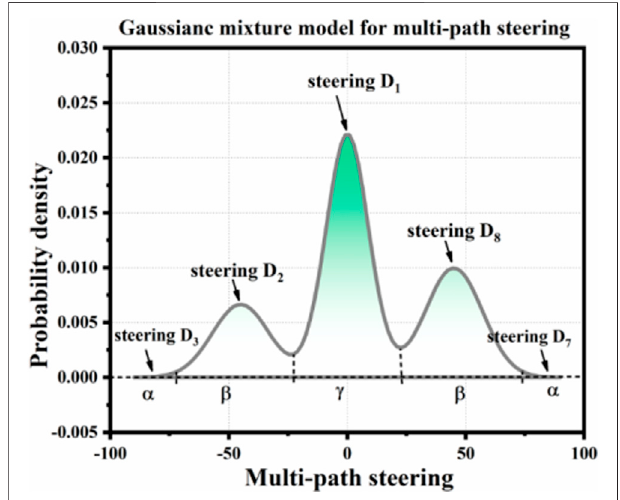
FIGURE 15 | Steering unmixing Gaussian distribution function